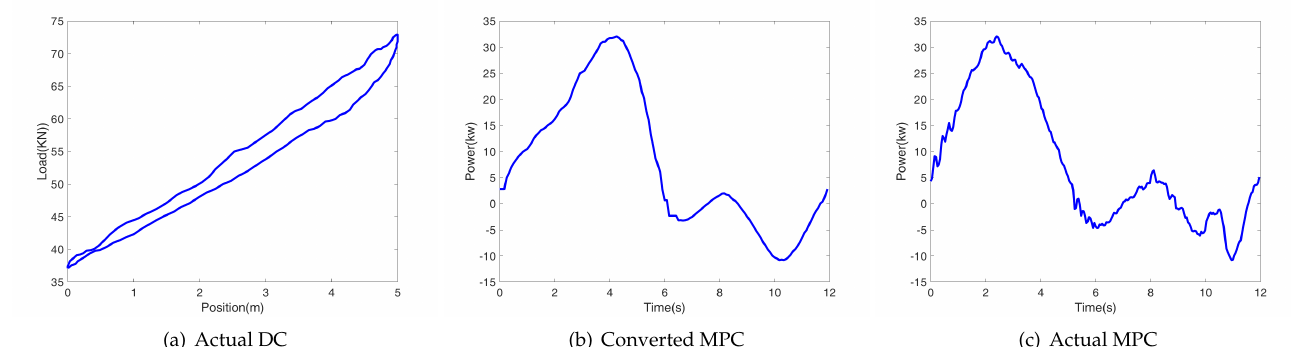
Figure 9. Gas-affected working state.